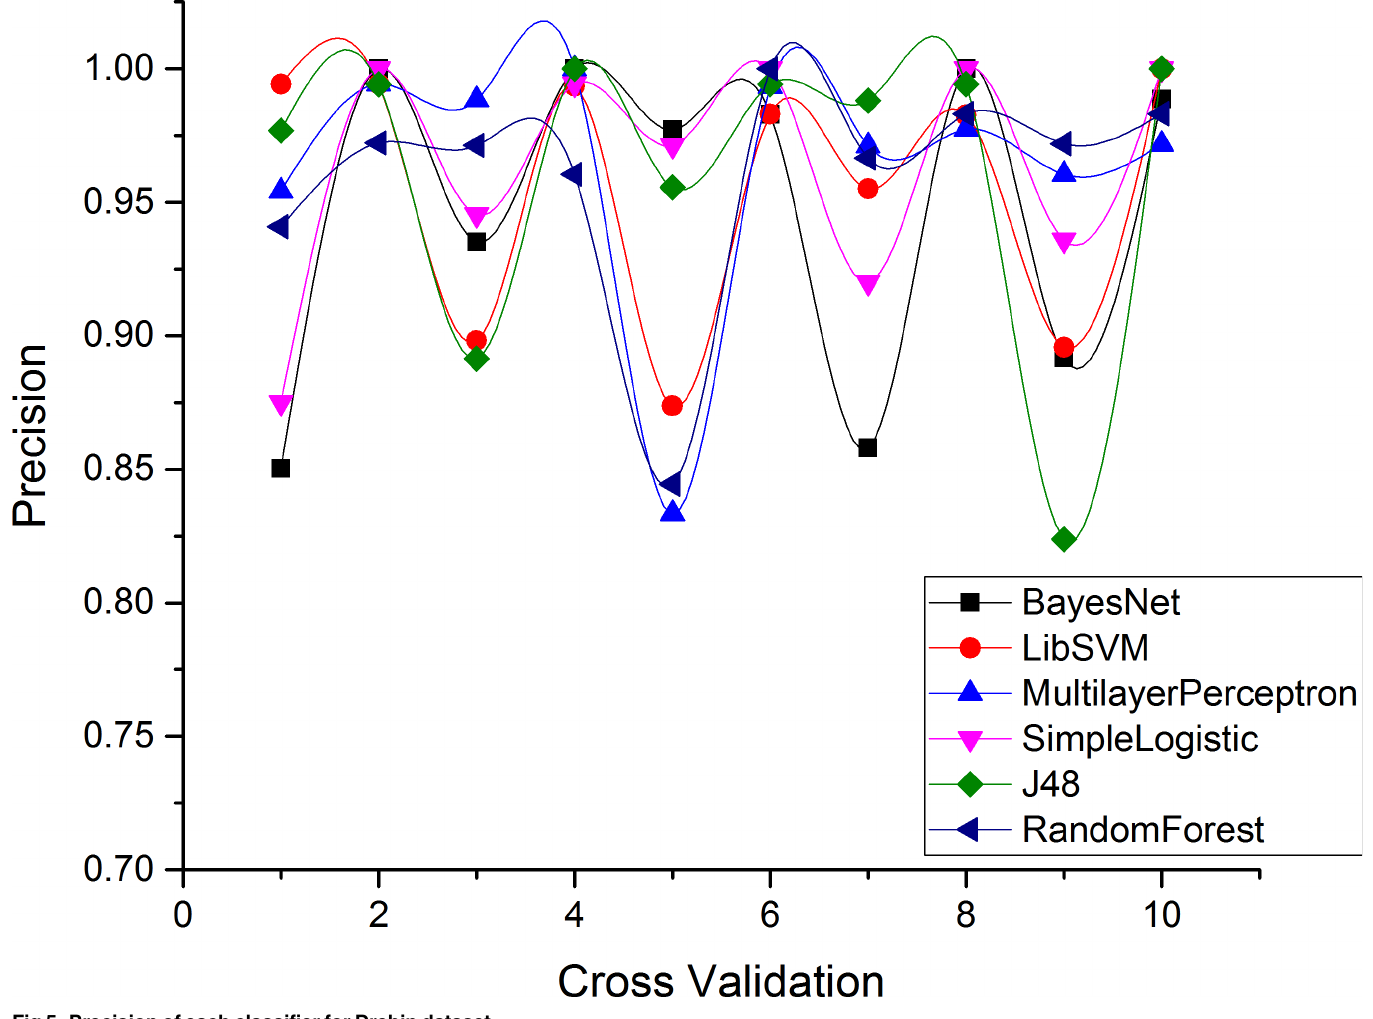
Fig 5. Precision of each classifier for Drebin